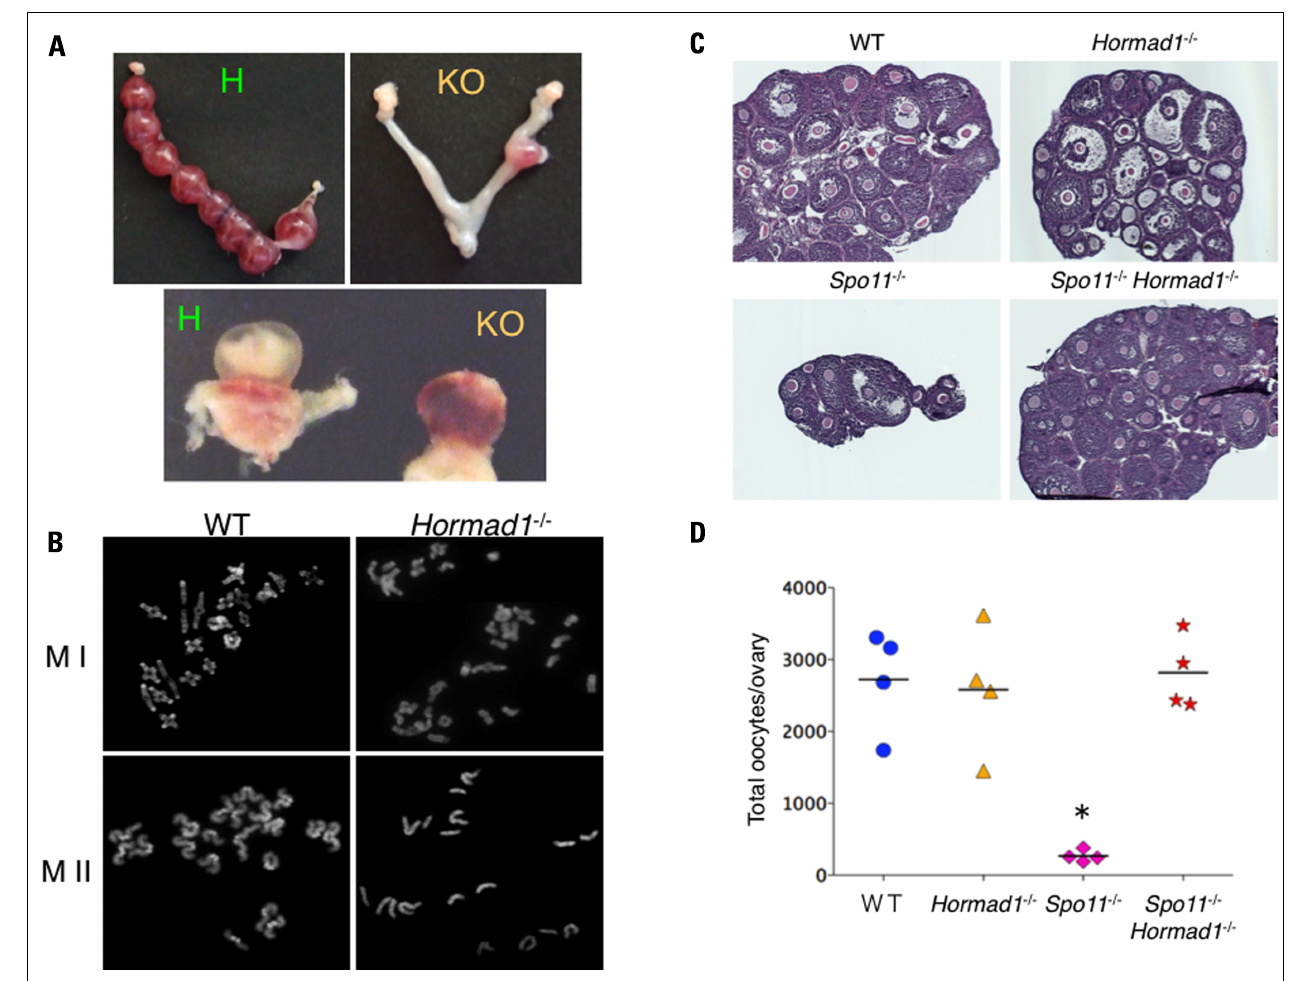
metaphase (MII) of Hormad1-deficient oocytes with some monovalents (right). (C) Hematoxylin and eosin staining of ovary sections from 20-day-old female mice.The ovaries from Spo11-deficient mice are small with only a small number of follicles, while Spo11 / Hormad1 double-knockout mice demonstrate the same size and oocyte number as the wild-type levels. (D) The number of oocytes in 20-day-old mice ovaries.The c-Kit positive oocytes are almost absent in the Spo11-deficient ovary, but are abundant in the Spo11 / Hormad1 double-knockout ovaries (* P <